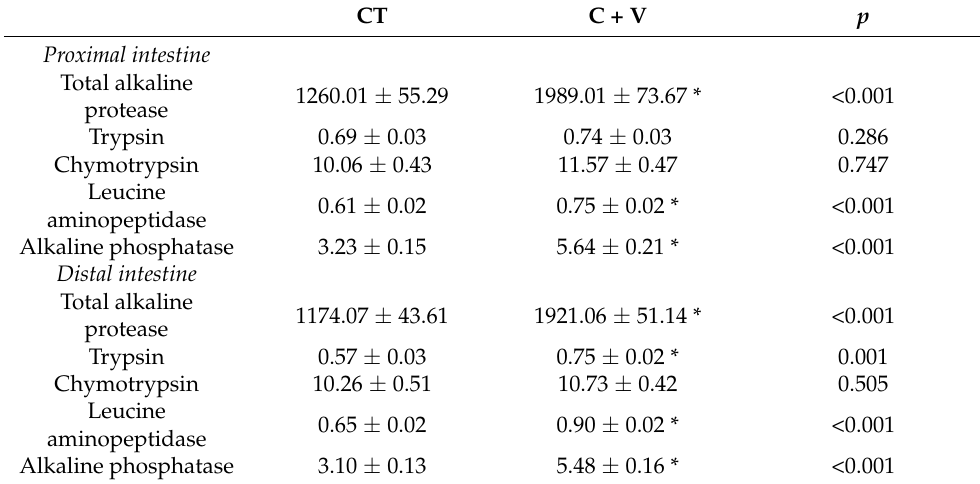
Table 8. Digestive enzyme activity (U g tissue −1 ) measured in the intestinal extracts obtained from the proximal and distal intestinal regions of juvenile C. labrosus fed the control (CT) or the C. fusca + V. proteolyticus (C + V) diets for 90 days .